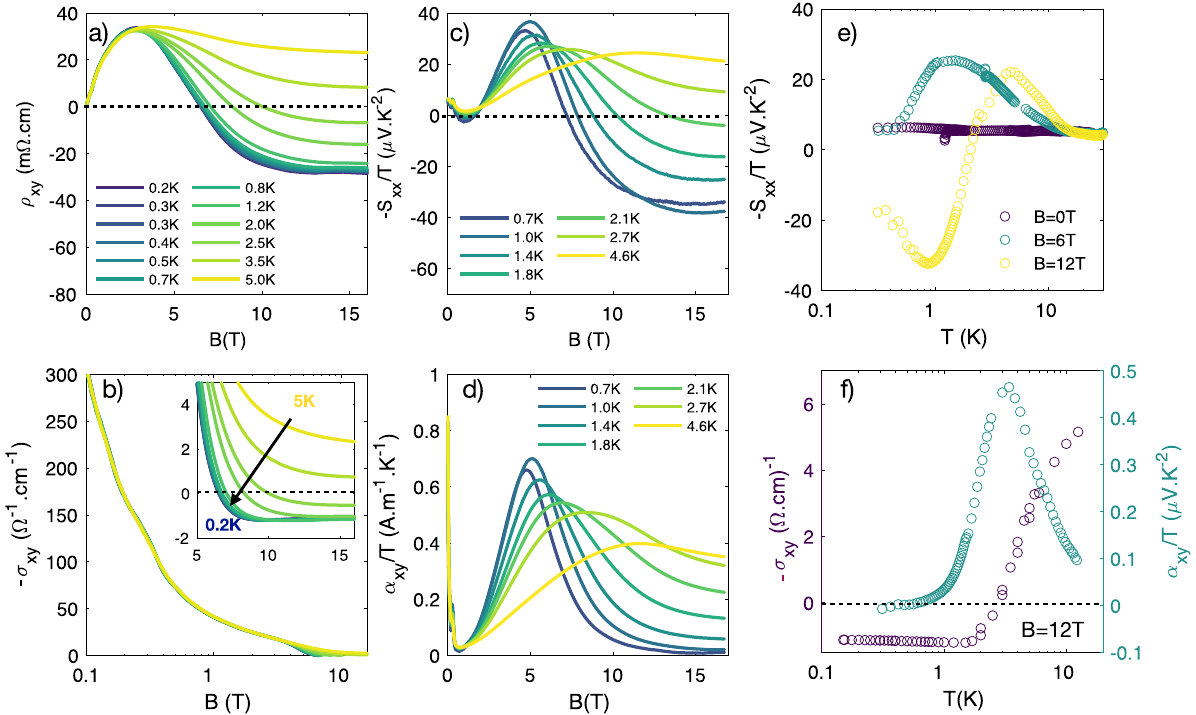
ρ xy ρ xx (cid:1) ρ yy þ ρ 2 xy we assumed here that = at T T